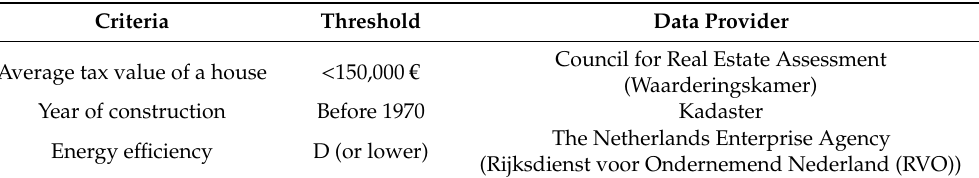
Table 6. Criteria for identification of areas suitable for urban development. (Source: authors).